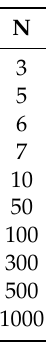
Table 2. Critical Values ∆ R adapted from